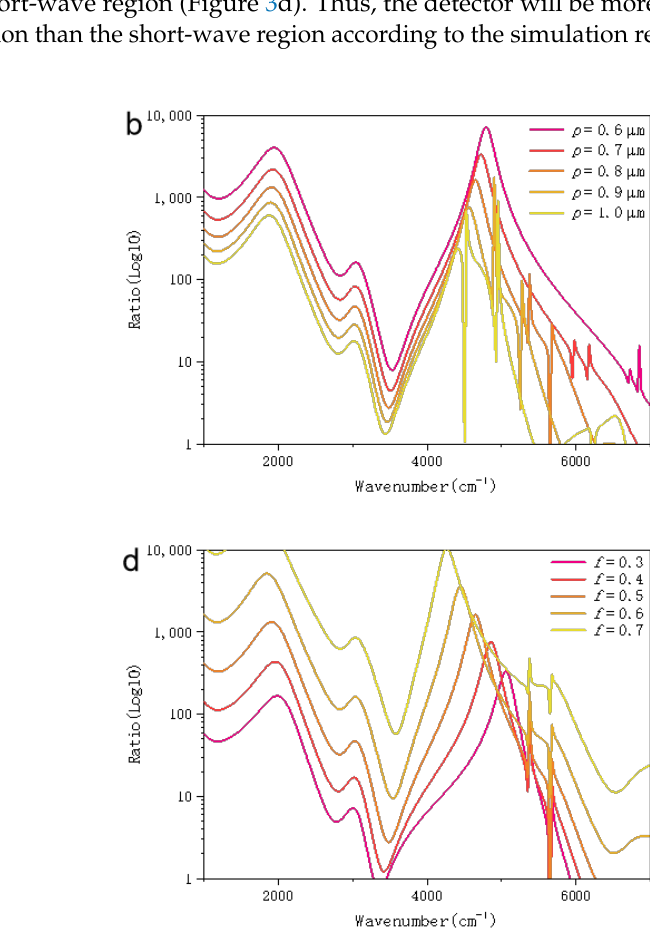
Figure 2. ( a ) Influence of different periods on polarization performance and absorption rate in short- wave region. ( b ) Extinction ratio for different periods in short-wave region. The thickness of metal wire grid is 100 nm. Duty cycle f is 0.5. The thickness of SiO 2 is 340 nm. The thickness Si is 140 nm. ( c ) Influence of different duty cycle on polarization performance and absorption rate in short-wave region. ( d ) Extinction ratio for different duty cycle in short-wave region. Thickness of metal wire grid is 100 nm. The period p is 0.8 μm. The thickness of SiO 2 is 340 nm. The thickness Si is 140 nm.